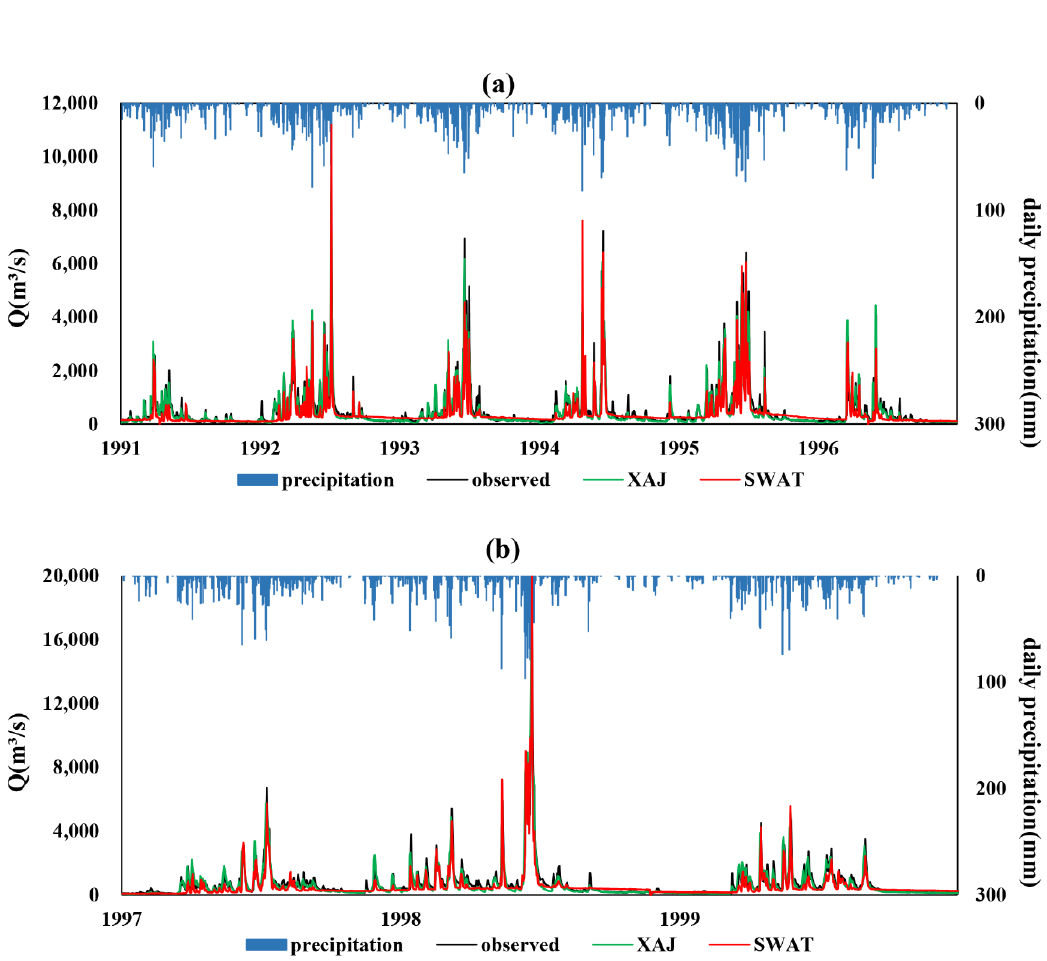
Figure 3. ( a ) Comparisons between the observed and simulated daily discharge for the calibration period and ( b ) comparisons between the observed and simulated daily discharge for the validation period. For better readability, the maximal of Y axes in ( b ) was limited to 20,000 m 3 /s. So, some of the maximum discharge, i.e., 20,290 m 3 /s, were not shown in the figure.